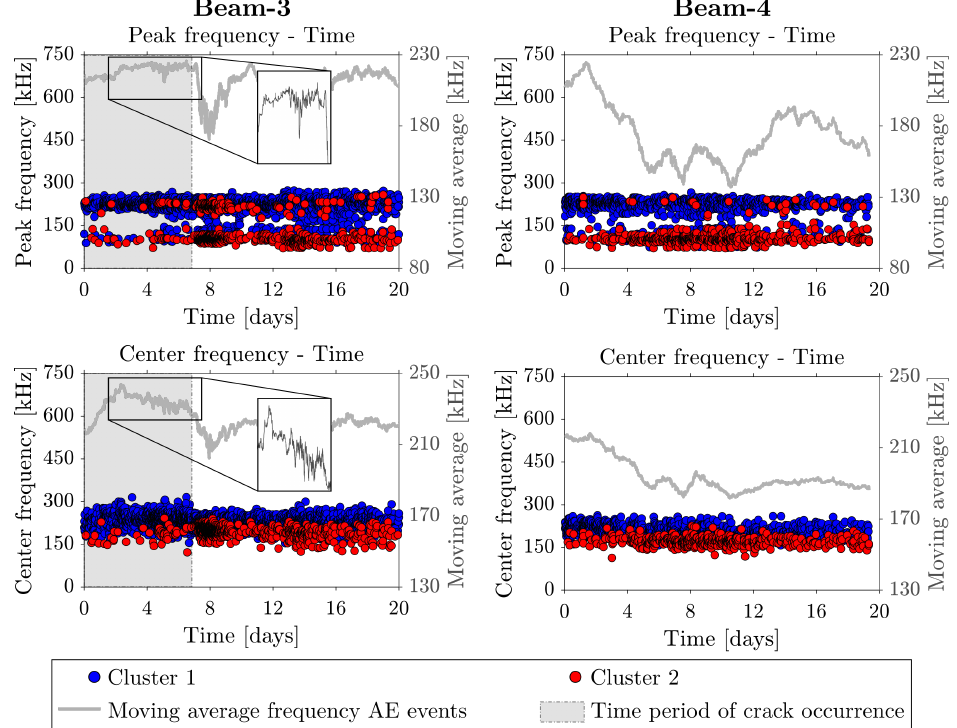
Figure 10. Clustering results for Beam-3 ( left ) and Beam-4 ( right ) represented as peak frequency ( top ) and center frequency ( bottom ) versus time. The period in which the surface crack occurred is indicated by the grey